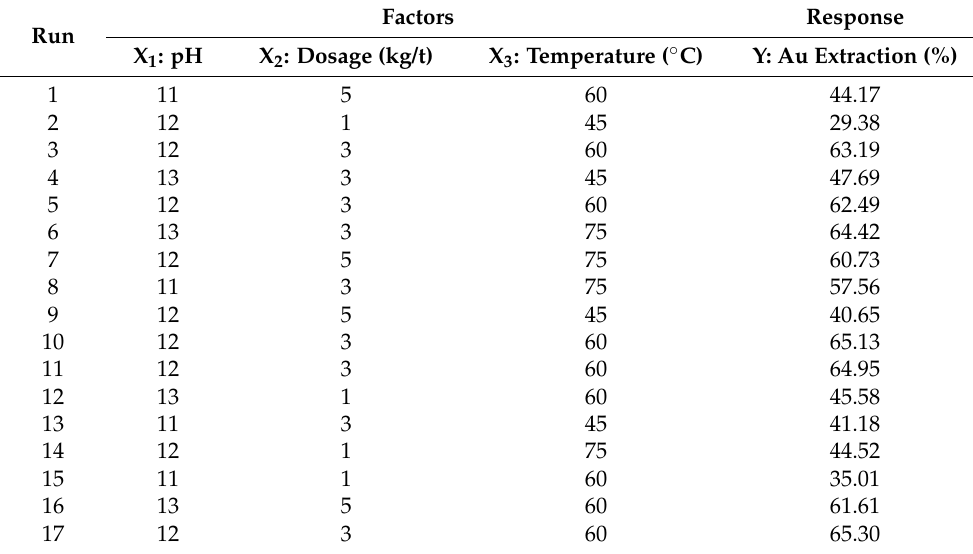
Table 4. Independent variables and their levels for the Box-Behnken design.